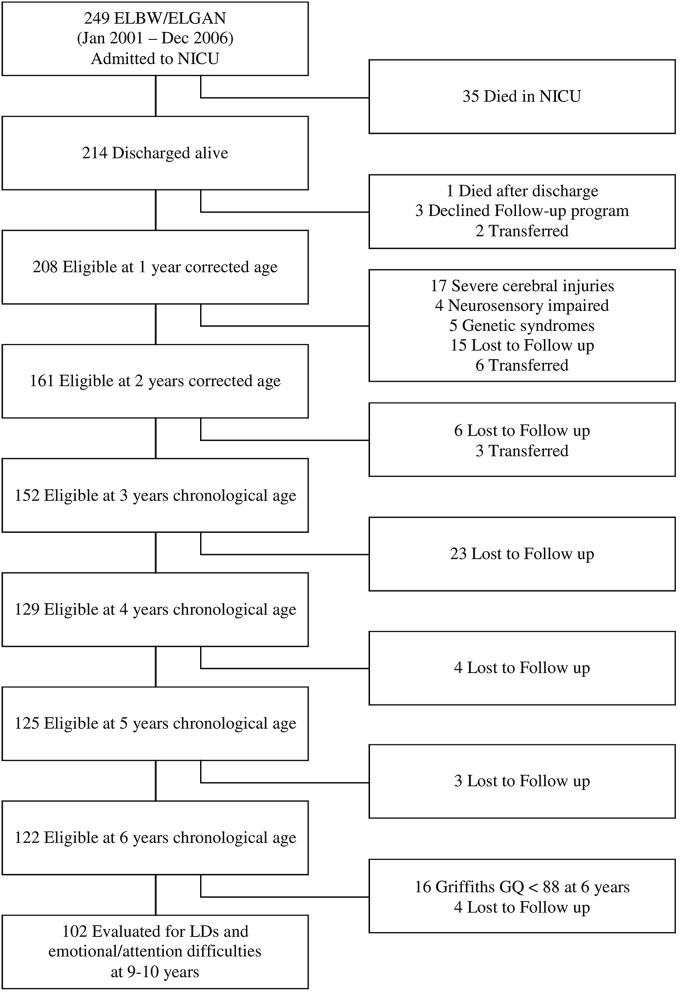
Flow chart of the study.